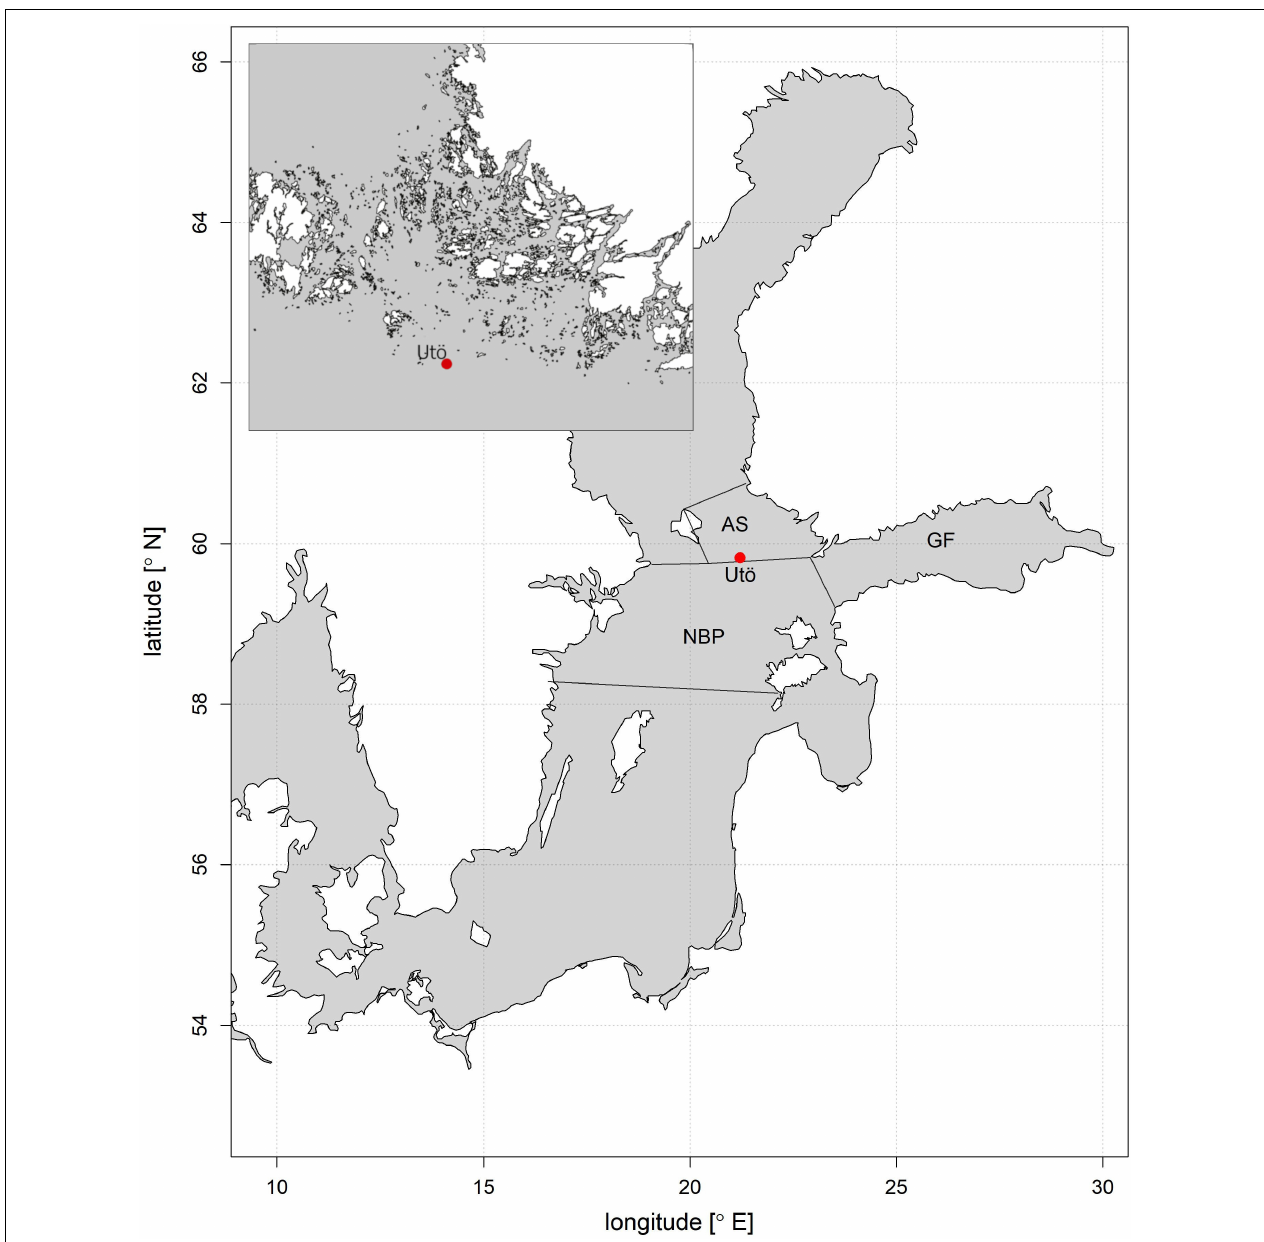
FIGURE 2 | The location of the study site in the Baltic Sea and the nearby sea areas (AS; Archipelago Sea, NBP; Northern Baltic Proper, GF; Gulf of Finland). A more detailed map of the sampling area in the upper left